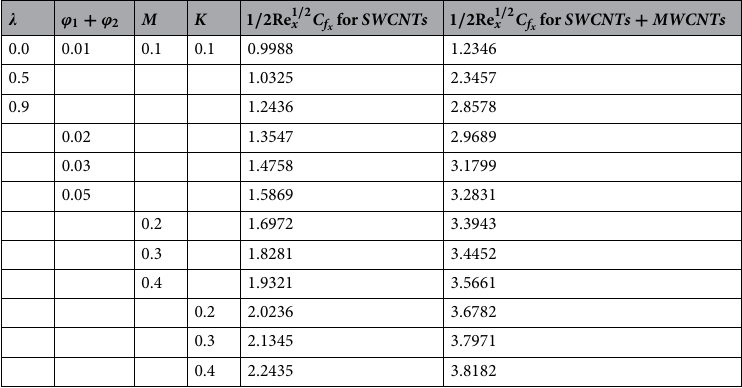
Table 3. Impact upon skin friction regarding different values of emerging